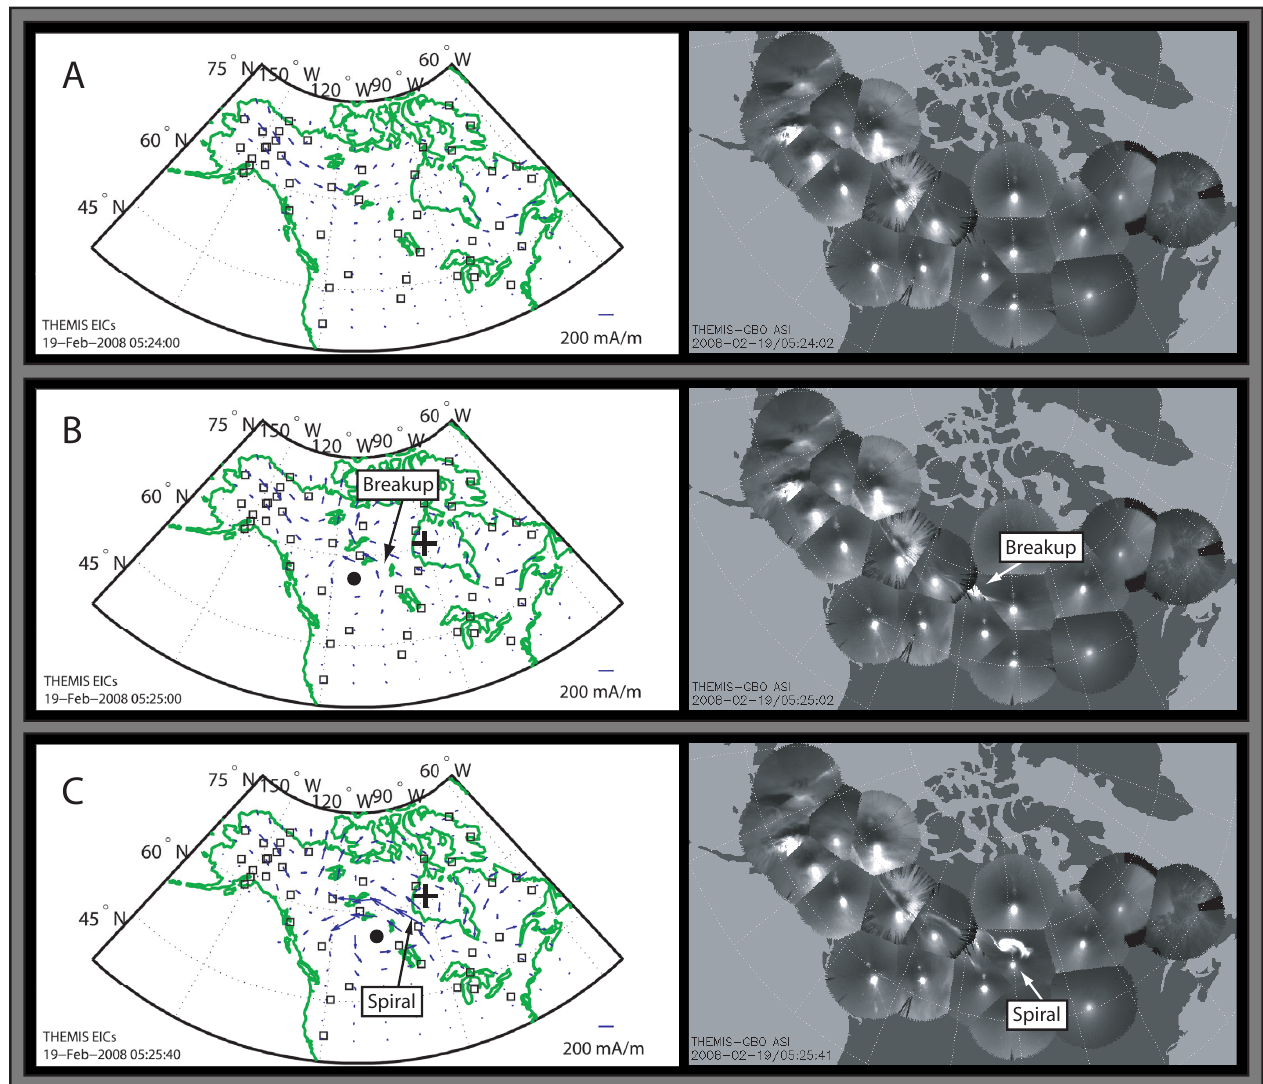
Fig. 5a. Equivalent ionospheric currents (EICs) in comparison to ASI images during the (a) first and (b) second auroral spiral on 19 February 2008. The dot and cross, overlaid on the EICs, mark the center of counter-clockwise and clockwise EIC vortices. The open squares mark the locations of the ground stations used for the EIC